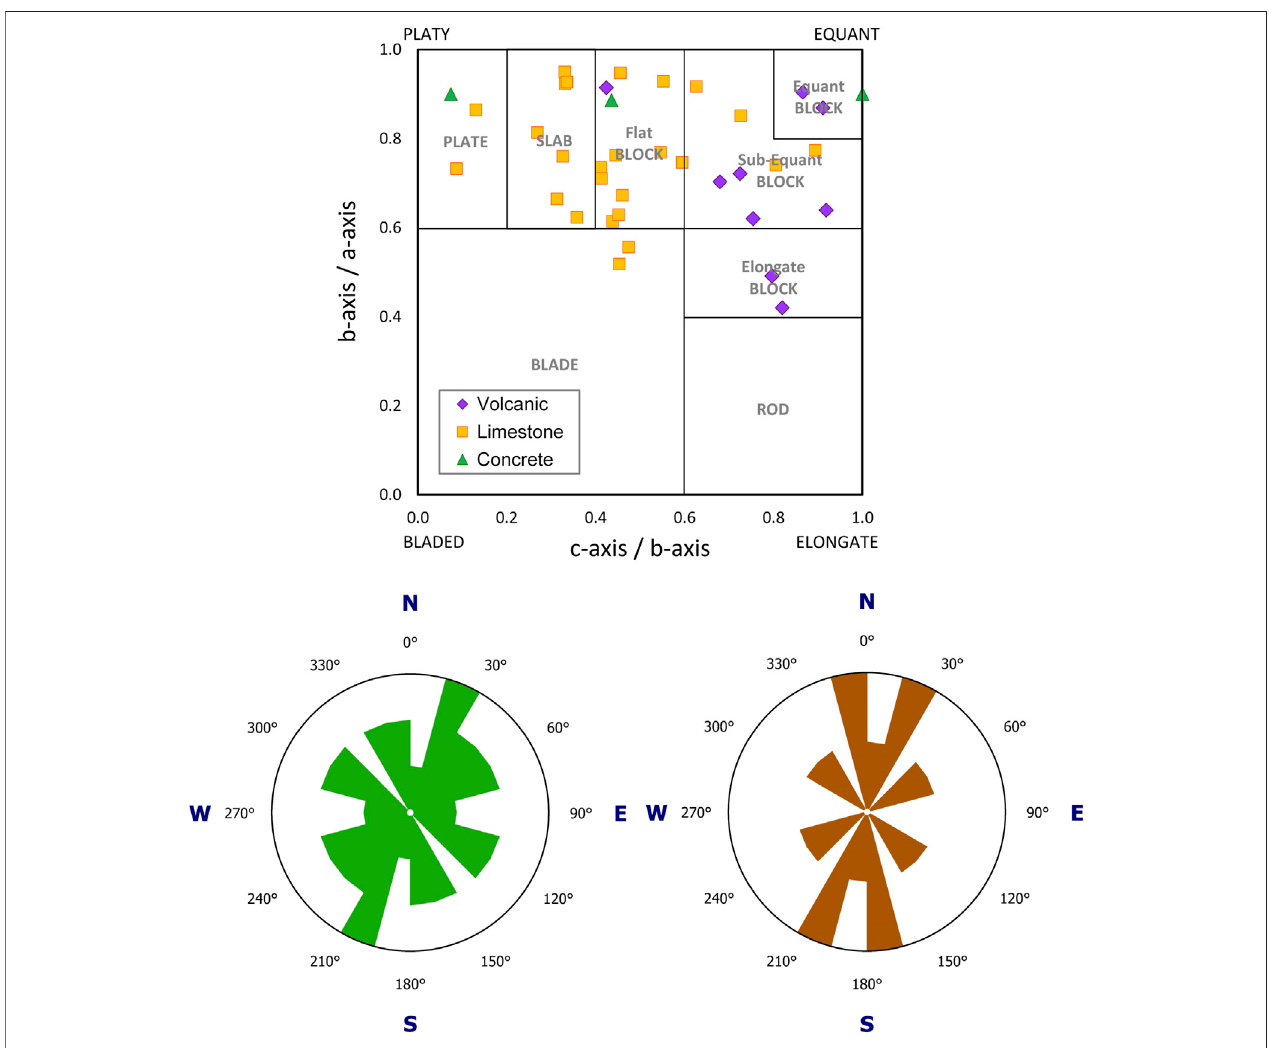
FIGURE6| Above: Measuredboulder 3Dform, plottedon aZingg diagram (Zingg, 1935;Blott and Pye, 2008).Below: Orientationoflong-axes forlimestone (left) and volcanic (right) clasts.